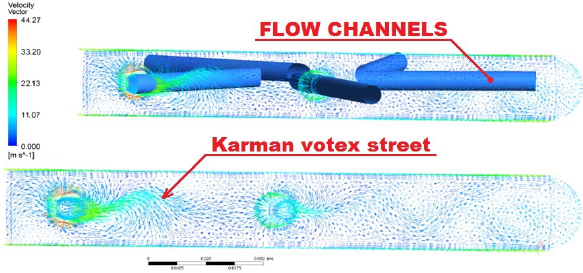
Figure 2: Vortex paths associated with the phenomenon of external flow around the pipes of impeller